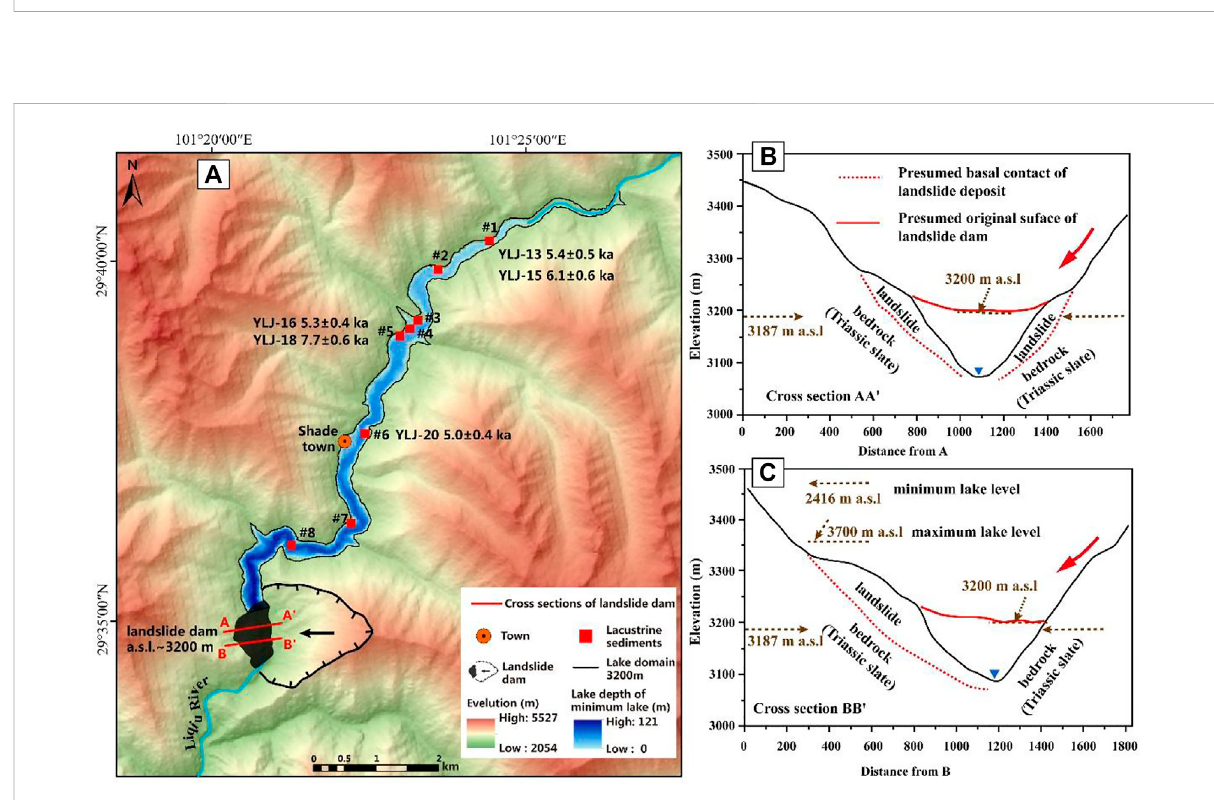
FIGURE 9 Paleo-extent and dam morphology of the Yuting landslide-dammed lake. (A) Paleo-extent of theminimum and maximum lake levels. The blue rampshowsthelakedepthataminimumlakelevelof3,187 ma.s.l.Theblacklineisthelakedomainatthemaximumlakederivedat3,200 ma.s.l. (B) and (C) Linegraphsofcross-sectionAA ’ andcross-sectionBB ’ .Theorientationofthecross-sectionsismarkedin (A) .Theydisplaythemorphologyof the lake outlet (relict dam), which illustrates the presumed original landslide surface and the dam